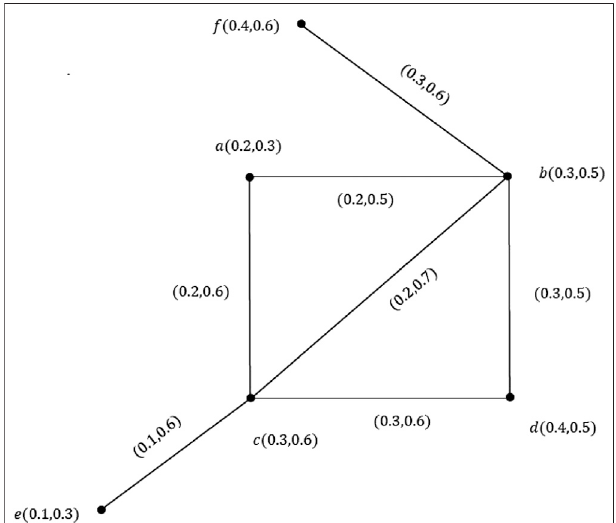
FIGURE 1 | EN degree of nodes in ζ .